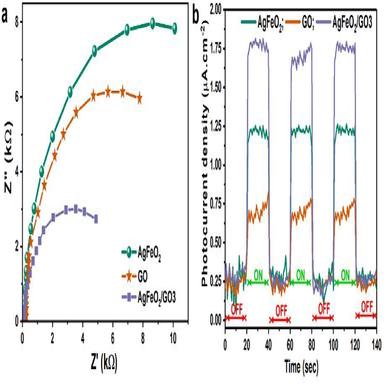
(a) EIS response of AgFeO2, GO and AgFeO2/GO3 with the presence of 3-/4- redox probe, (b) Photocurrent responses of AgFeO2, GO and AgFeO2/ GO3 with periodic switching of the light source.